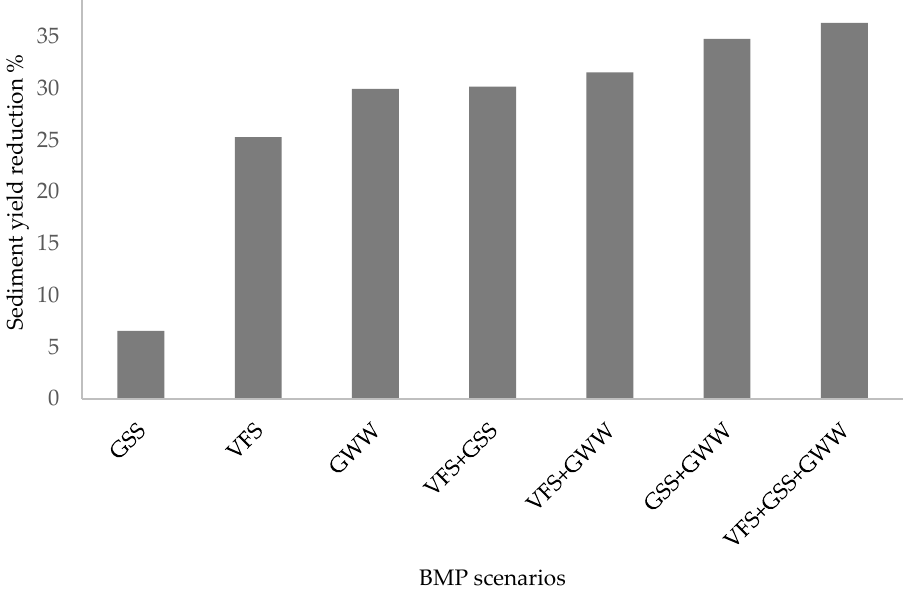
Figure 6. Average annual sediment yield reduction for different BMP scenarios at the watershed level.